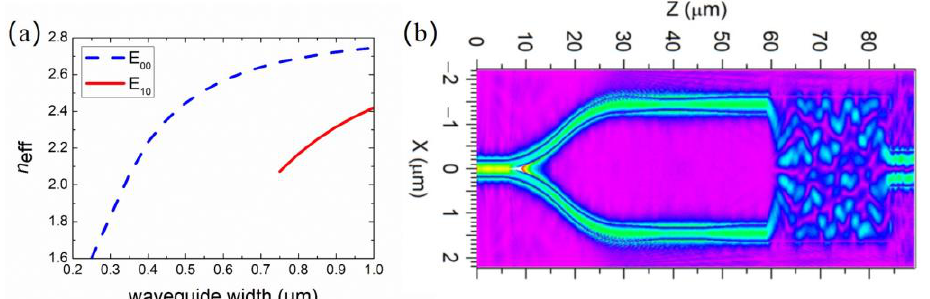
Figure 3. ( a ) The effective indices of E 00 and E 10 modes as a function of core layer waveguide width with 220 nm silicon core thickness, ( b ) mode field distribution of mode converter at 1550 nm.